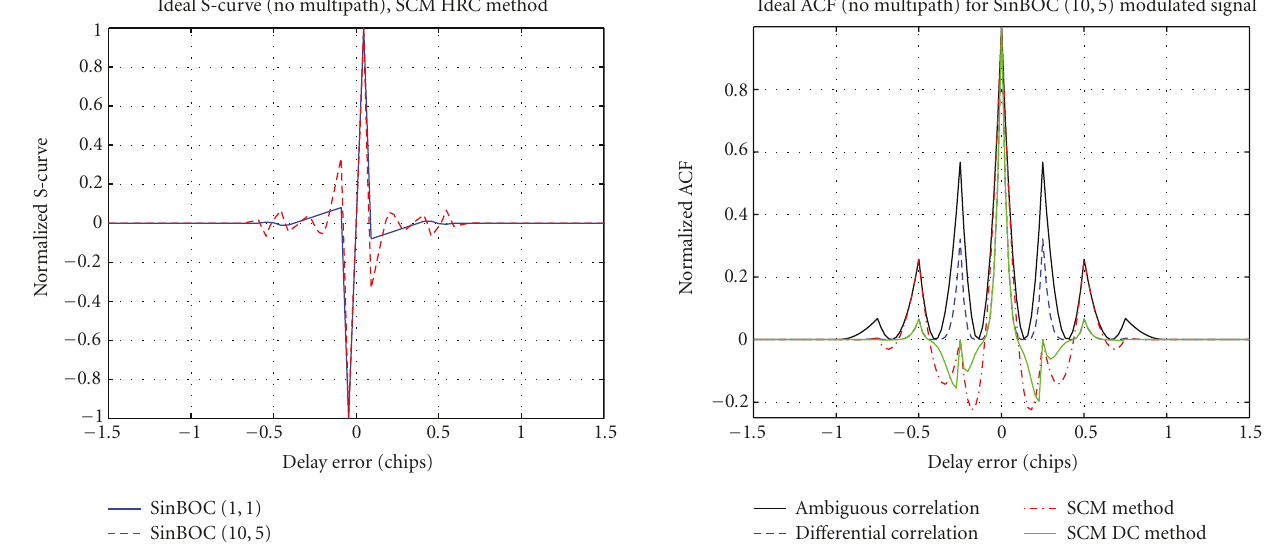
Figure 15: Envelopes of correlation functions obtained with am- biguous correlation, DC method, SCM approach, and SCM DC method, for a SinBOC(10,5)-modulated